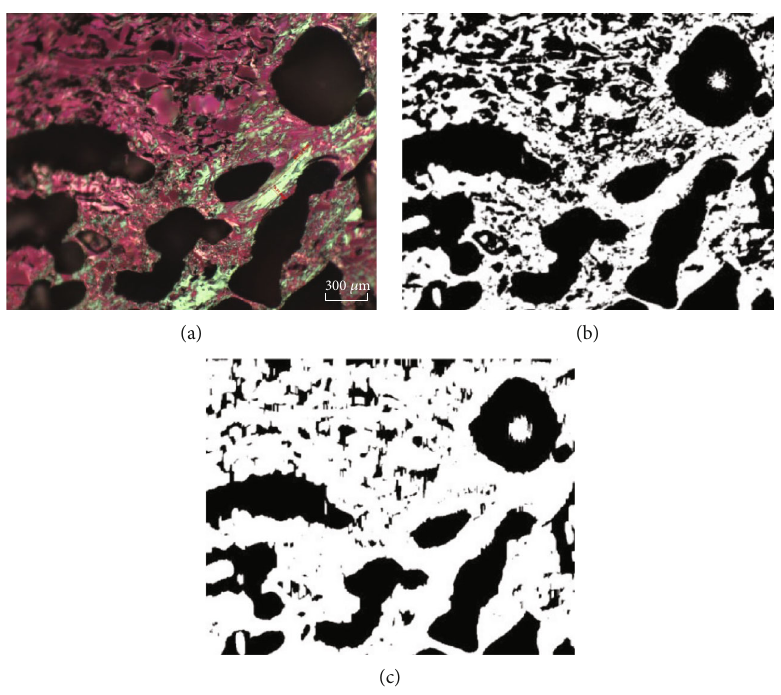
Figure 6: Image binarization: (a) original; (b) adaptive threshold binarization; (c) morphological fi ltering adaptive threshold binarization.